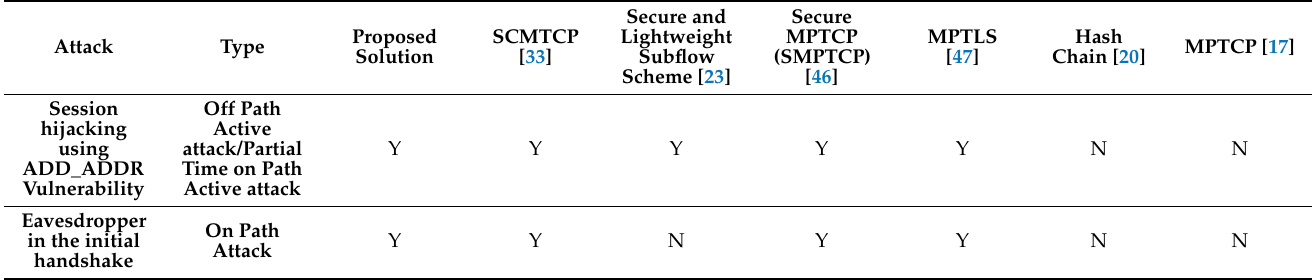
Table 5. Comparative evaluation of existing security solutions against attack